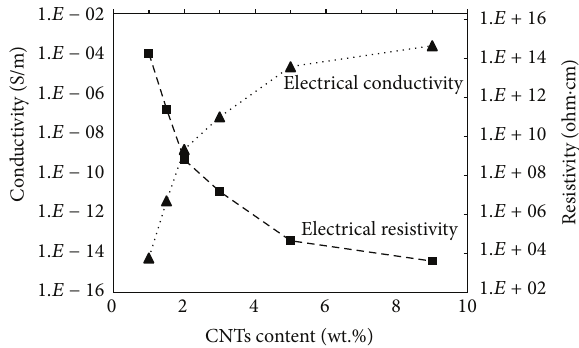
Figure 5: Variation of electrical resistivity and conductivity with increase in CNTs